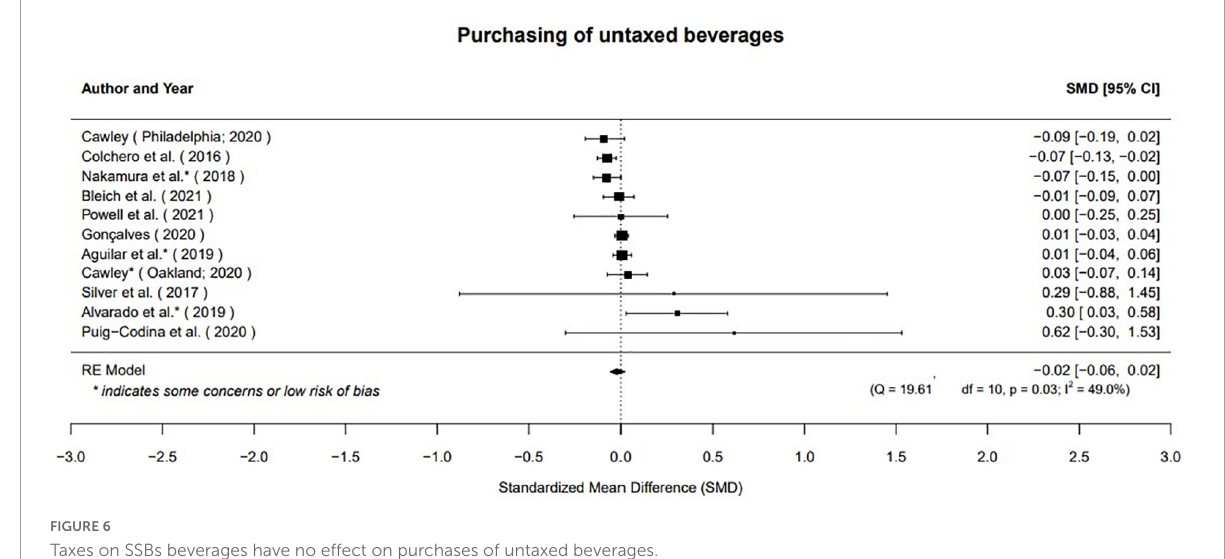
FIGURE6 Taxes on SSBs beverages have no effect on purchases of untaxed beverages.